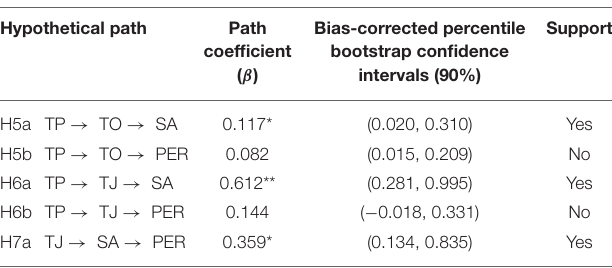
TABLE 9 | Path analysis—indirect